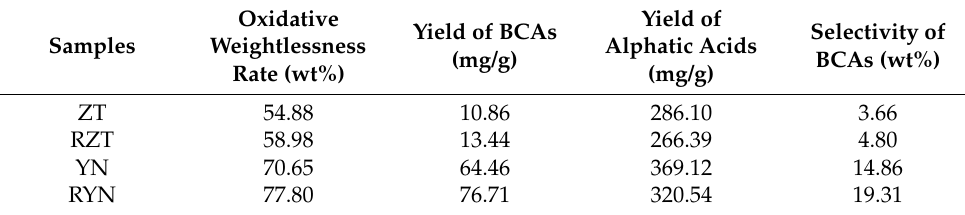
Table 2. The results from oxidation of ZT, RZT, YN, and RYN a